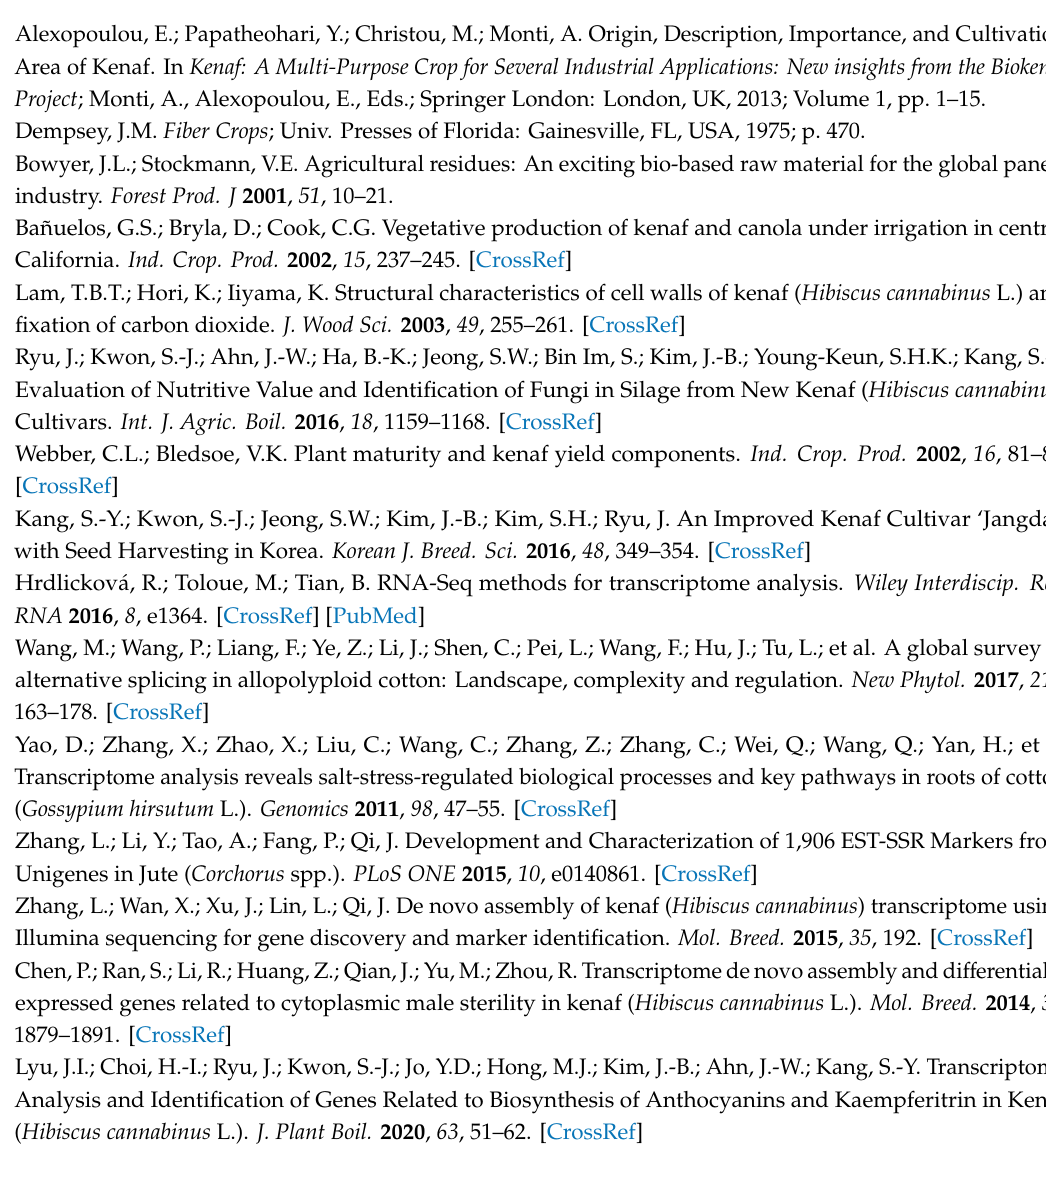
Table S1: Primer information used for qPCR analysis, Table S2: Detailed information of the final gene set with representative isoforms, Table S3: GO terms to the final set of 11,370 unigenes. Functional groups under the three main categories: cellular components, biological process, and molecular function, Table S4: Detailed information of the KEGG classification